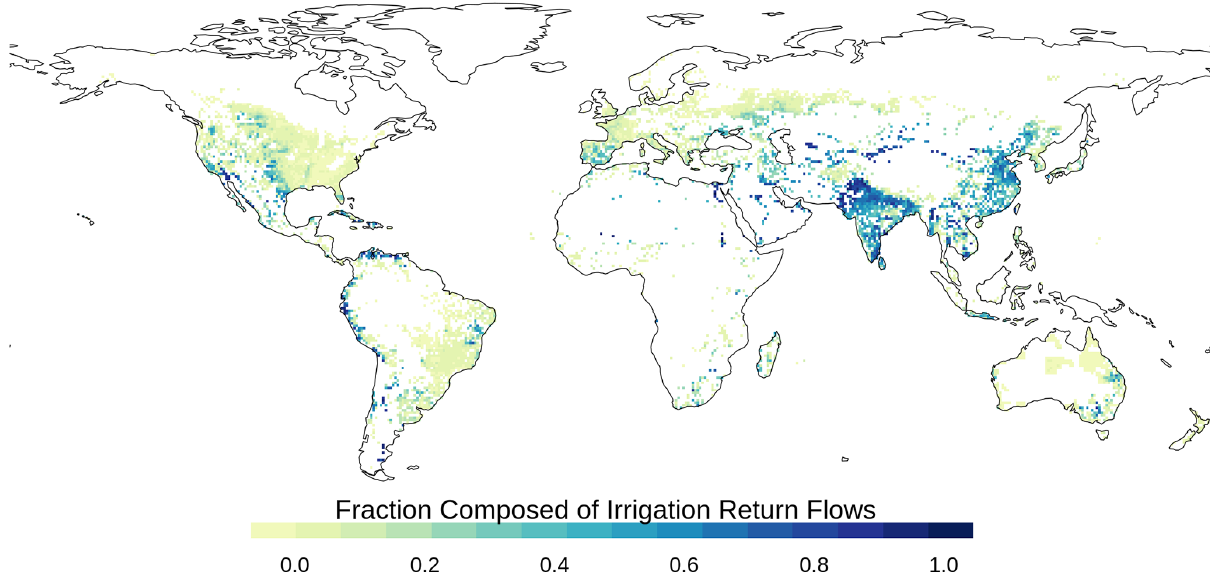
Figure 12. Fraction of average annual irrigation withdrawals composed of prior irrigation returns simulated by the return flow tracking